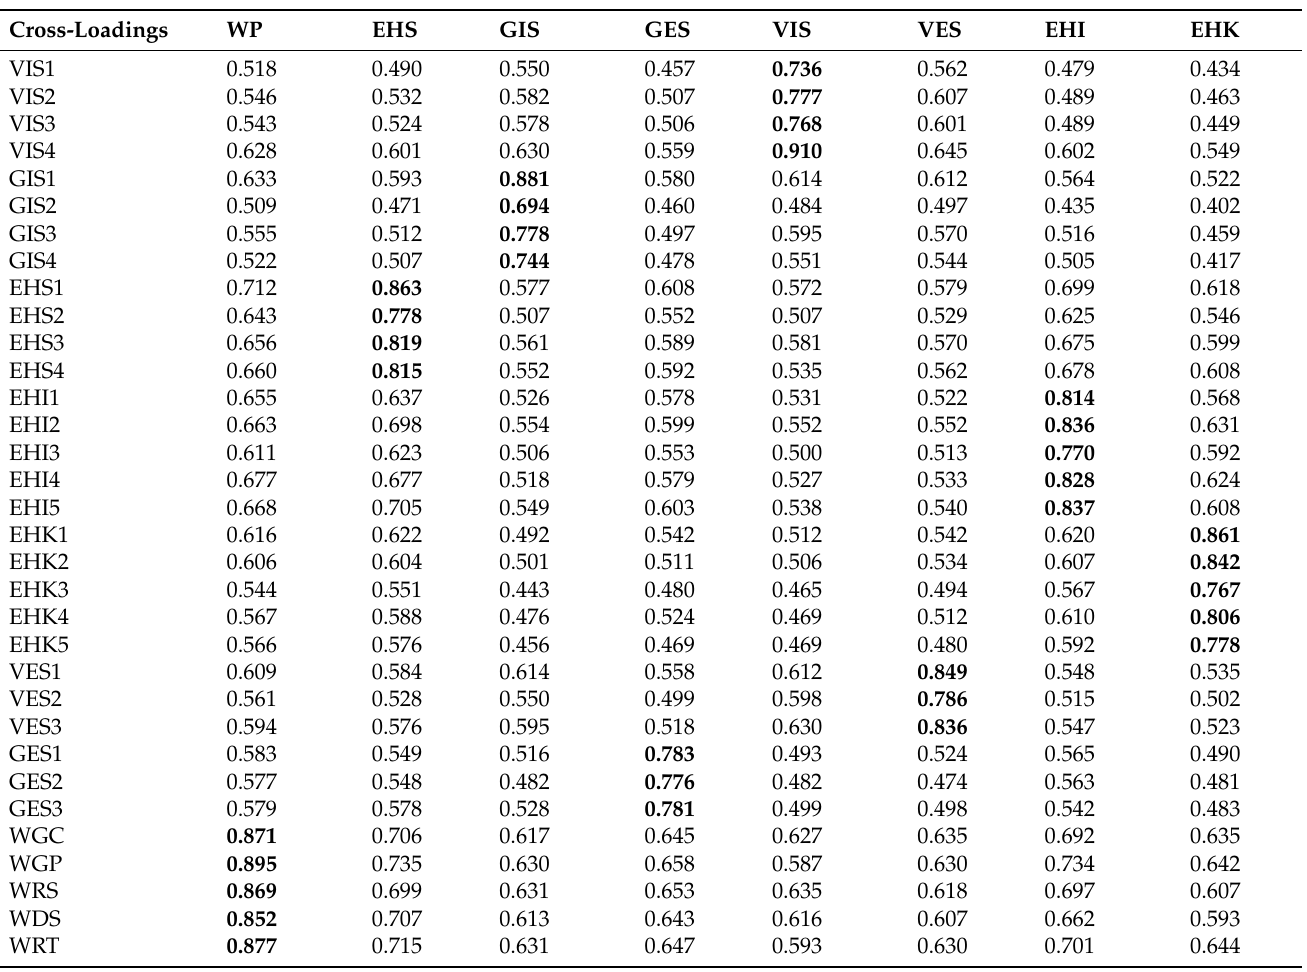
Table 4. Cross-loadings on each